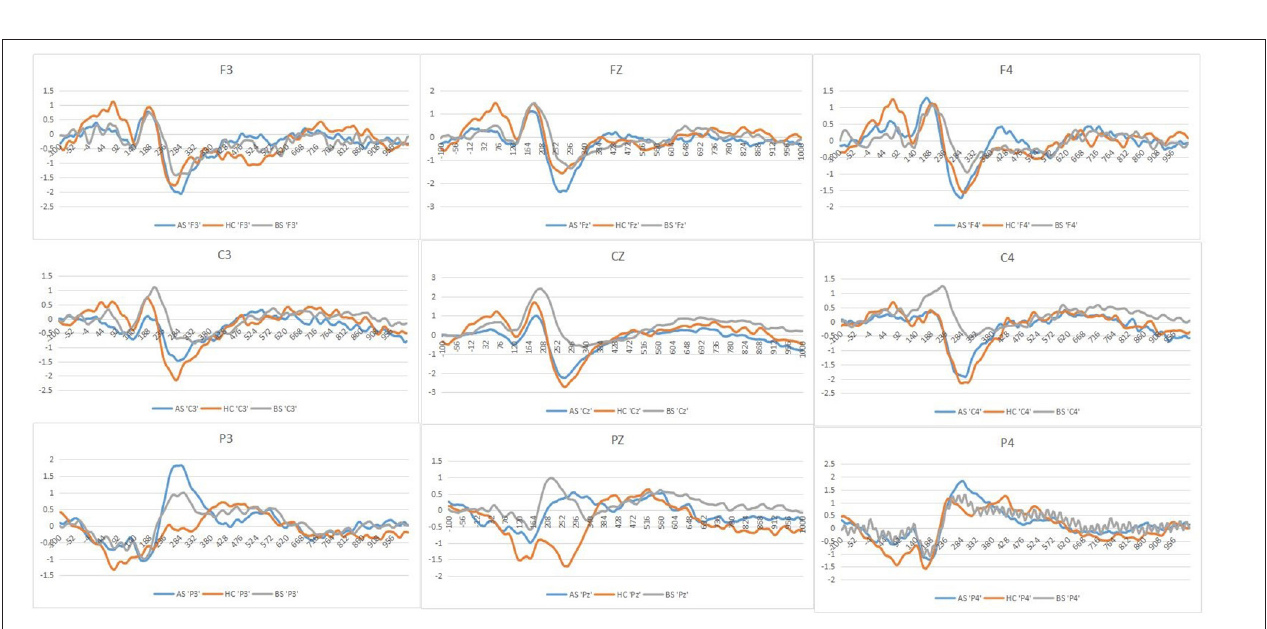
FIGURE 4 | Grand averages in response to negative stimuli of the three groups at each of the nine ERPs electrodes employed in the present experiment stimuli (AS or postoperative group, BS or preoperative group, HCs or Healthy controls).